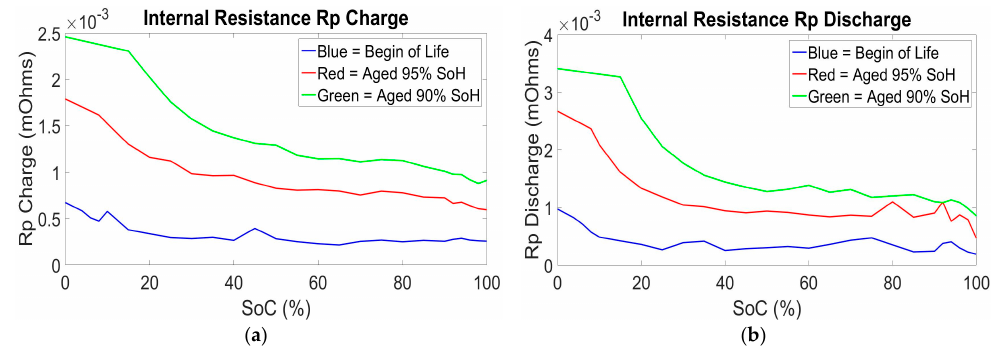
Figure 5. R o difference between a fresh BoL and aged (95% and 90% SoH) lithium ion cell: ( a ) R o charge; and ( b ) R o discharge.